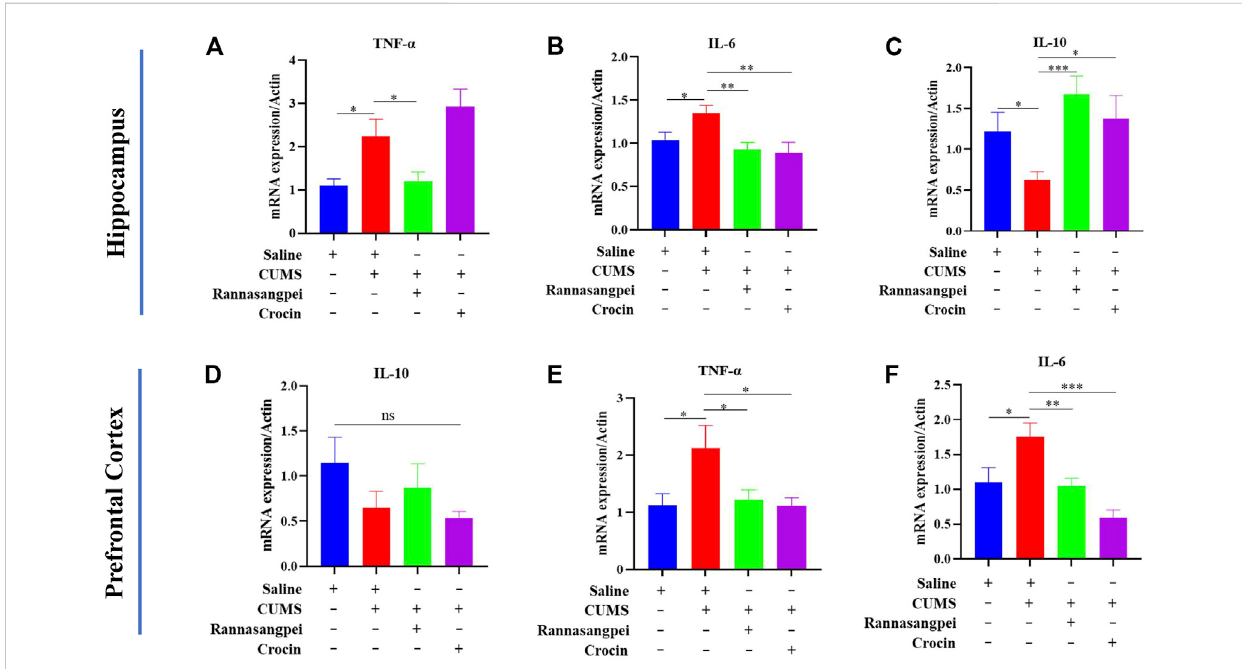
FIGURE 4 RSNP and crocin-1 inhibited in fl ammatory response in the brains of CUMS-treated mice (A) RSNP, but not crocin-1 inhibited CUMS-induced upregulation of TNF- α transcriptional expression in the hippocampus. (B) Both RSNP and crocin-1 inhibited CUMS-induced upregulation of IL-6 transcriptional expression in the hippocampus. (C) Both RSNP and crocin-1 restored CUMS-induced downregulation of IL-10 transcriptional expression inthehippocampus. (D) IL-10transcriptionalexpressionlevelsdidnotshowsigni fi cantdifferencesamonggroupsintheprefrontalcortex.RSNPand crocin-1 inhibited CUMS-induced upregulation of TNF- α (E) and IL-6 (F) transcriptional expression inthe prefrontal cortex. It should be noted that all the data were normalized to the saline group. TNF, tumor necrosis factor; IL, interleukin; RSNP, rannasangpei; CUMS, chronic unpredictable mild stress. N = 9. For ANOVA statistics: (A) , F (3,36) = 8.050, p < 0.001; (B) , F (3,36) = 4.283, p = 0.012; (C) , F (3,36) = 3.833, p = 0.018; (D) , F (3,36) = 1.280, p = 0.306; (E) , F (3,36) = 3.885, p = 0.023; (F) , F (3,36) = 8.922, p < 0.001. * p < 0.05, ** p < 0.01, *** p <